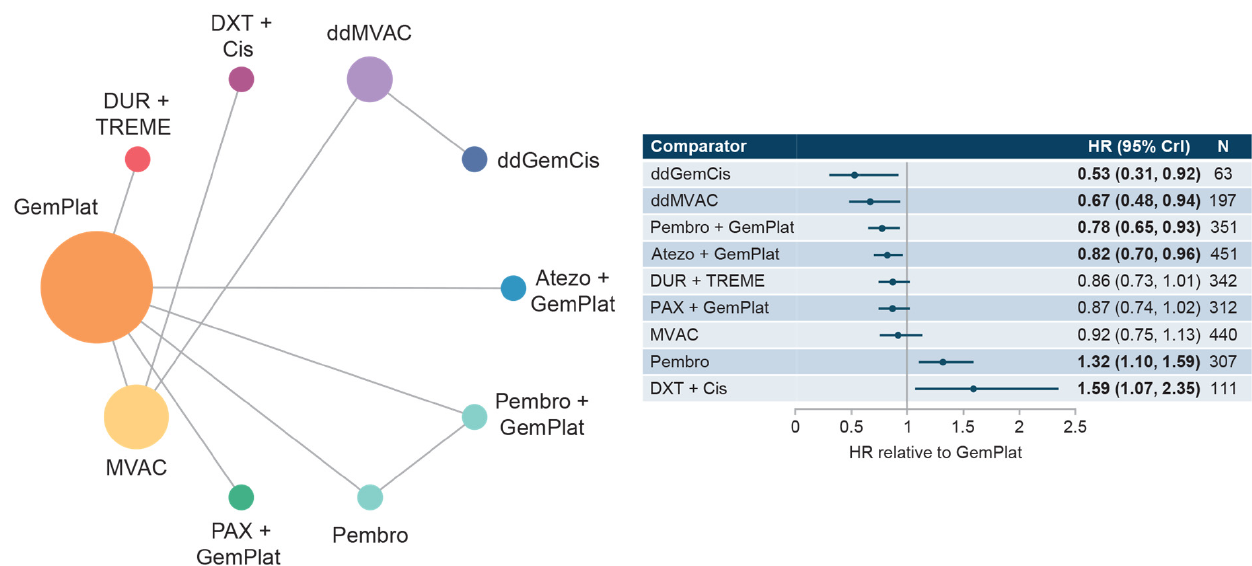
Figure 4. Network diagram and HR for PFS by treatment network for the cis-eligible/mixed net-